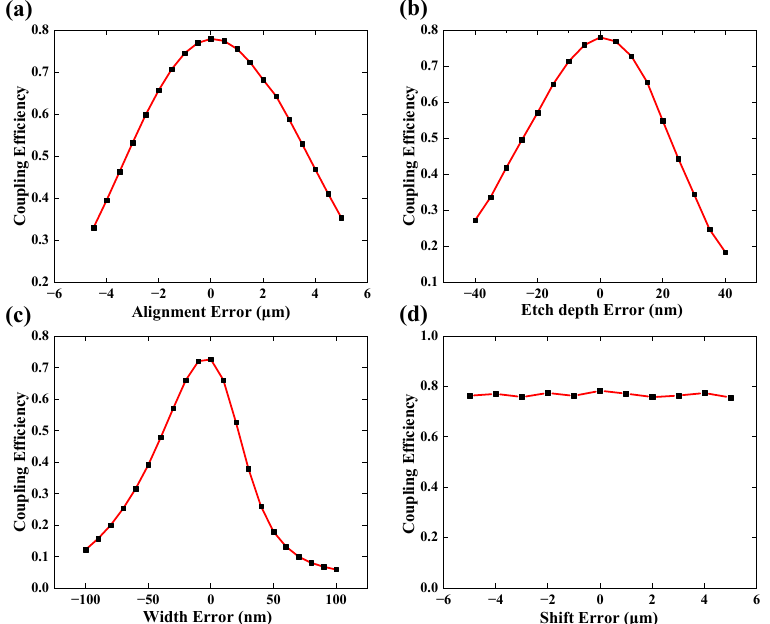
Figure 5. Coupling efficiency versus fabrication errors. ( a ) The alignment error between the source and GC. ( b ) The etch depth error in the etching process of GC. ( c ) The width error in the etching process of the GC and the meta-deflector. ( d ) The overlay shift error between two layers.